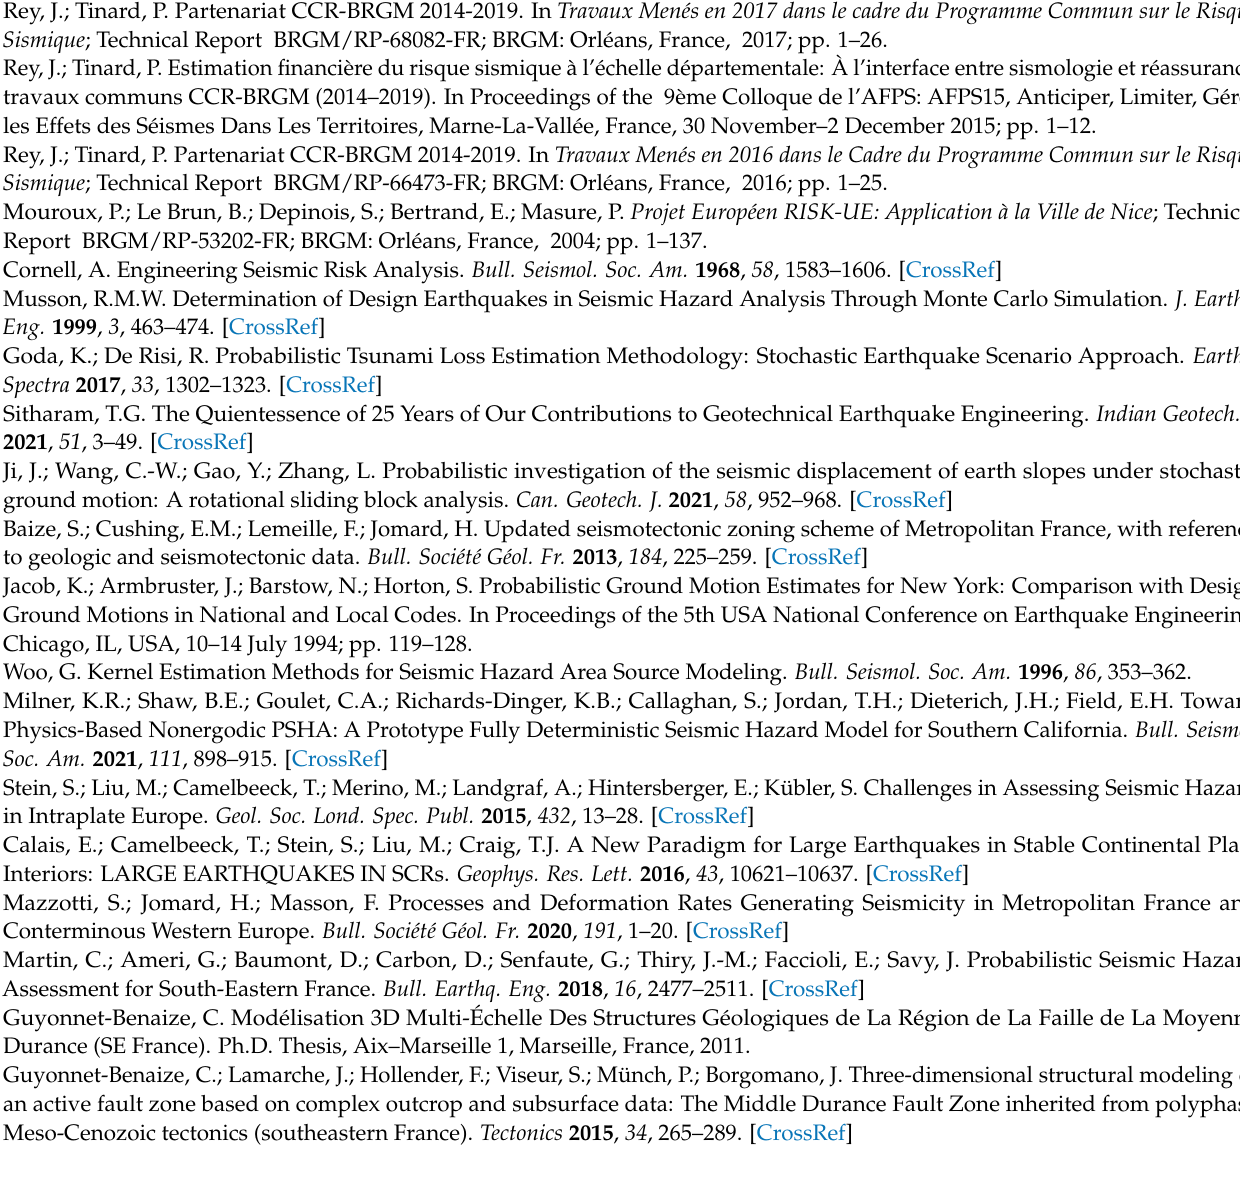
One can see that the two extreme b-values, 0.72 and 1.36 (Table A3), are obtained with the lower number of data: 40 and 301 respectively. Thus, these values must be used